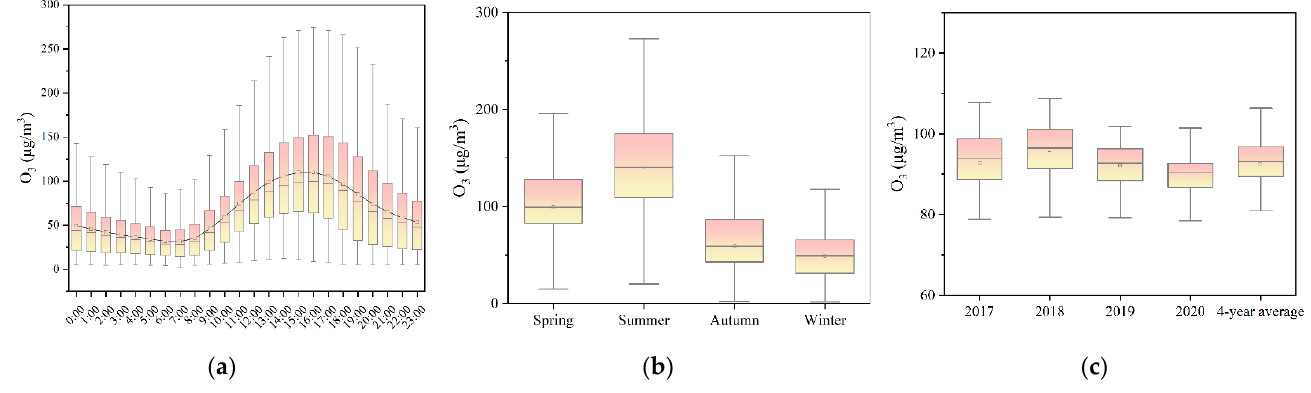
Figure 2. Variation characteristics of O 3 monitoring data from 2017 to 2020. ( a ) Hourly O 3 concentration, ( b ) seasonal maximum 8 h average O 3 concentration, and ( c ) annual maximum 8 h average O 3 concentration.